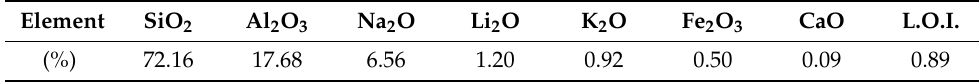
Table 4. Feed chemical analysis (L.O.I. = lost on ignition).